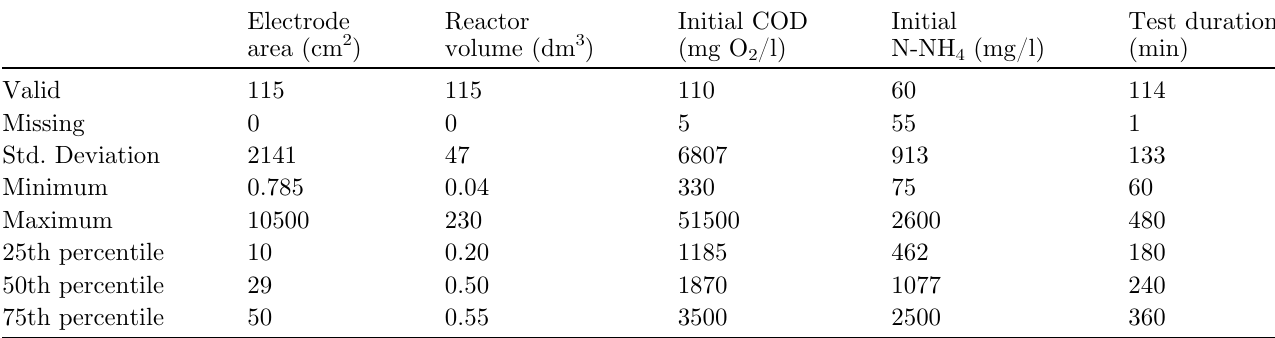
Table B1. Descriptive statistics of the observations obtained from the literature reported in Table